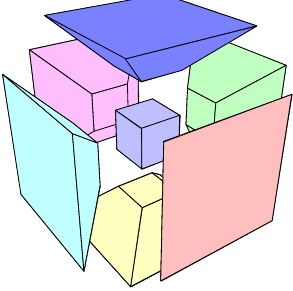
Figure 3. A visualisation of the volumes that form a tesseract, projected in 3D ( IR 3 ). The inner , front , back , left , right , top and bottom volumes are highlighted with different colours. For visualisation purposes, they have been moved apart from each other. In order to underpin the clarity of the figure, the outer volume is not